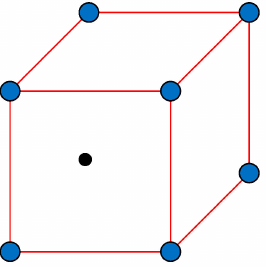
Figure 4. Schematic illustration of the cubic mesh